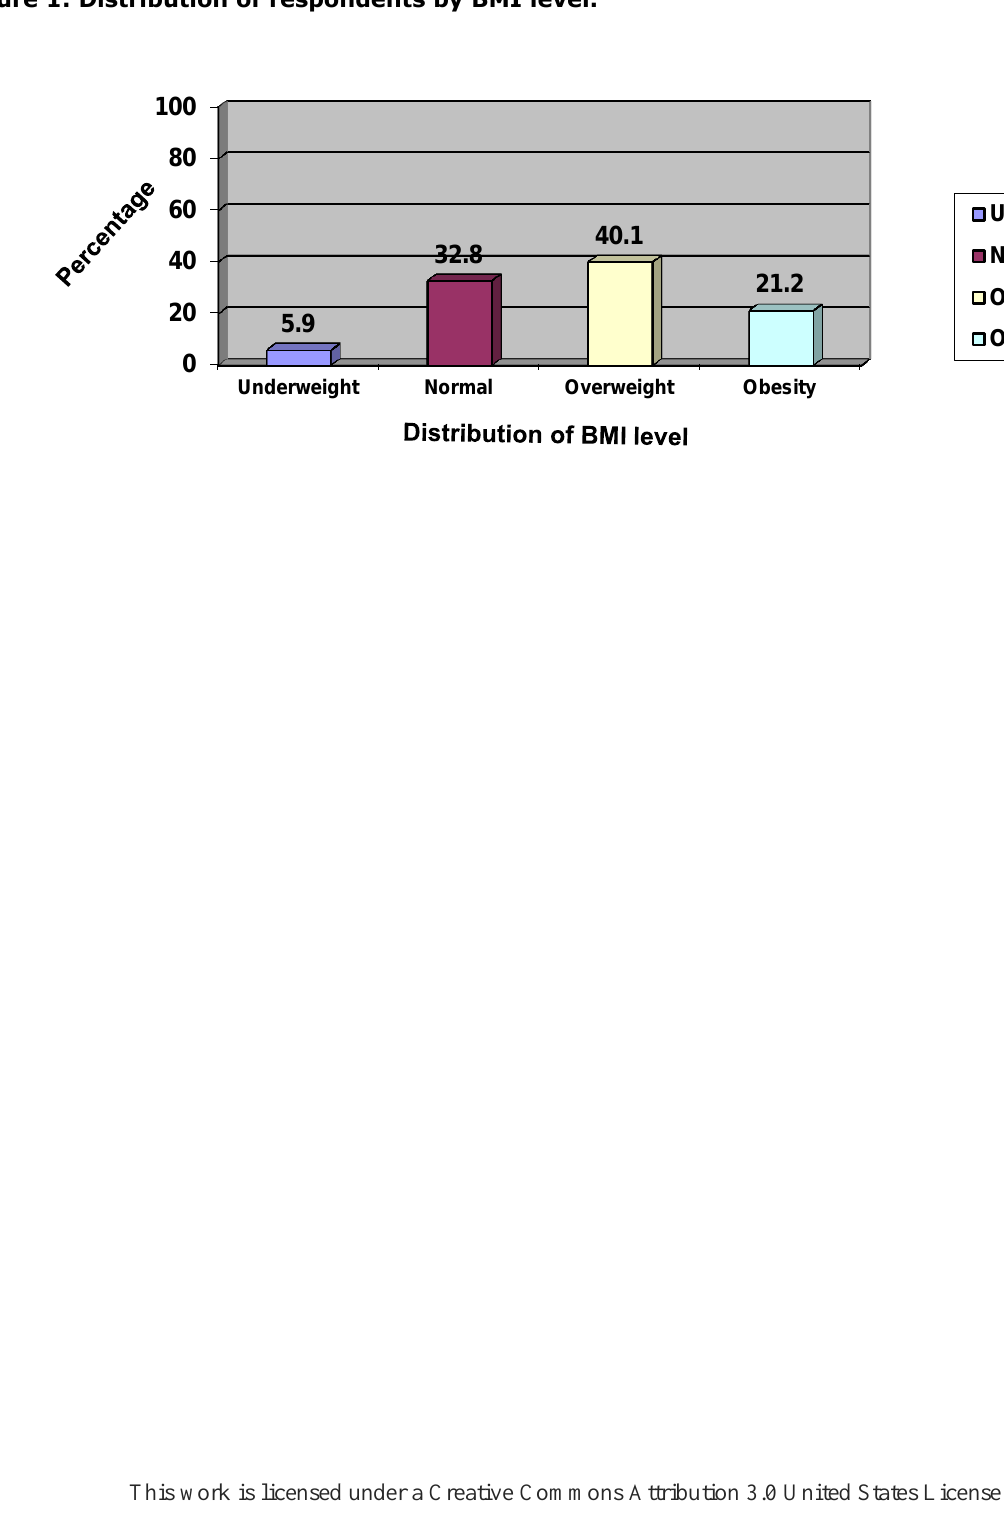
Figure 1: Distribution of respondents by BMI